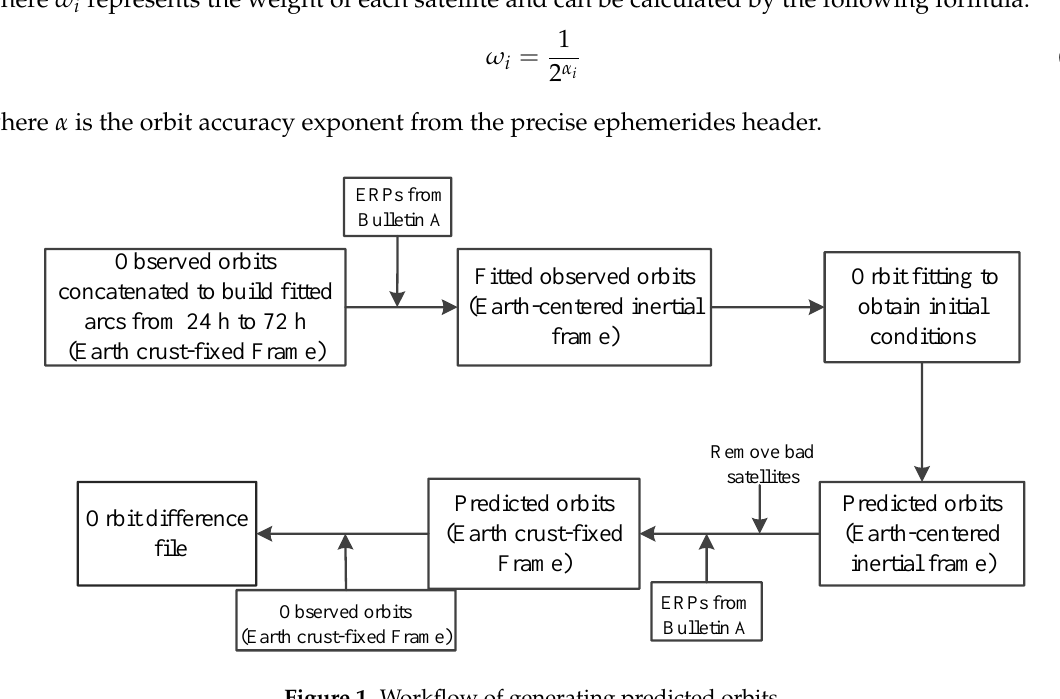
Figure 1. Workflow of generating predicted orbits.